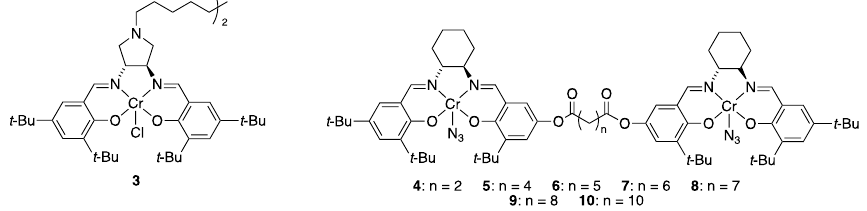
Figure 1. Bimetallic catalysts designed to evaluate the “head-to-head” geometry (catalyst 3 ) and the “head-to-tail” geometry (catalyst 4 – 10 ) of the bimolecular catalysis.